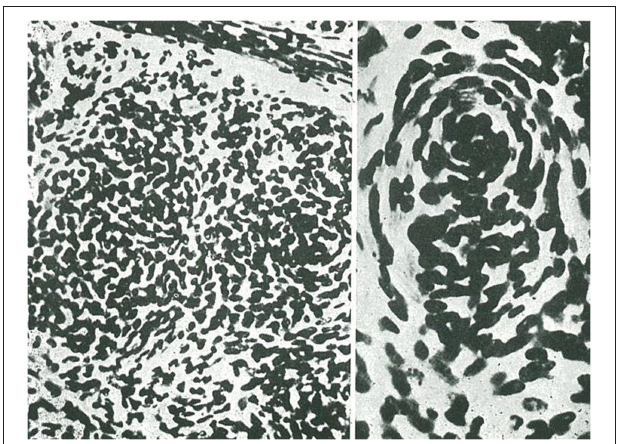
FIGURE 8 | Meningeal exothelioma. The disordered cells are forming clusters and concentric layers or acervuli (taken from Río-Hortega, 1933a).